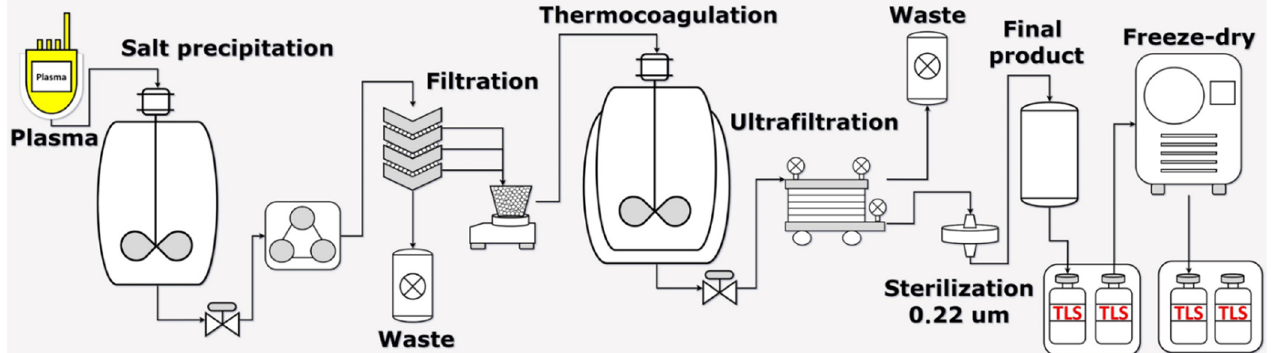
Figure 6. IgG purification scheme. The purification scheme of IgG is composed of two precipitation stages with ammonium sulfate. Three different kinds of filtration were used to purify the IgG, nominal, tangential (diafiltration and concentration), and sterile filtration.